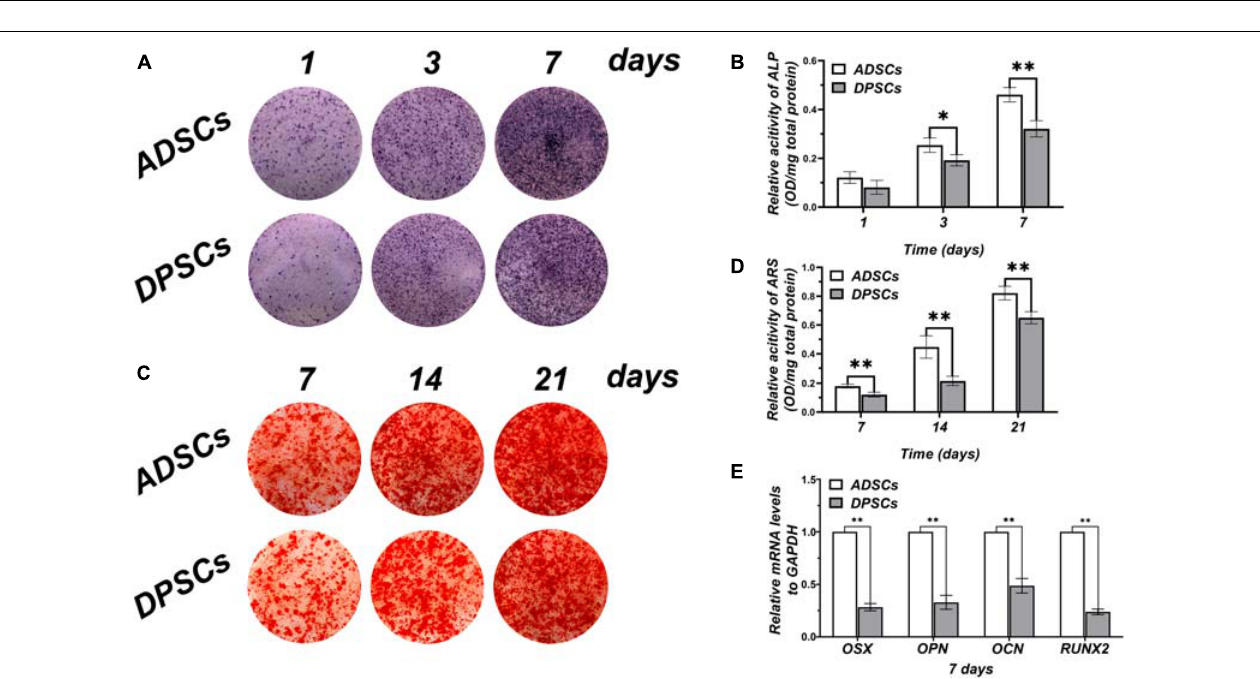
FIGURE 2 | Comparison of osteogenic differentiation abilities of ADSCs and DPSCs. (A) Alkaline phosphate (ALP) staining at 1, 3, and 7 days after osteogenic induction. (B) ALP activity in both groups at each time-point determined by ALP semi-quantitatively. (C) Alizarin red S (ARS) staining at 7, 14, and 21 days after osteogenic induction. (D) Mineral deposition in both groups at each time-point determined by ARS semi-quantitatively. (E) The mRNA expression levels of osteogenic related genes in DPSCs and ADSCs at 7 day. Data are presented as the mean ± standard deviation, * P < 0.05, ** P <